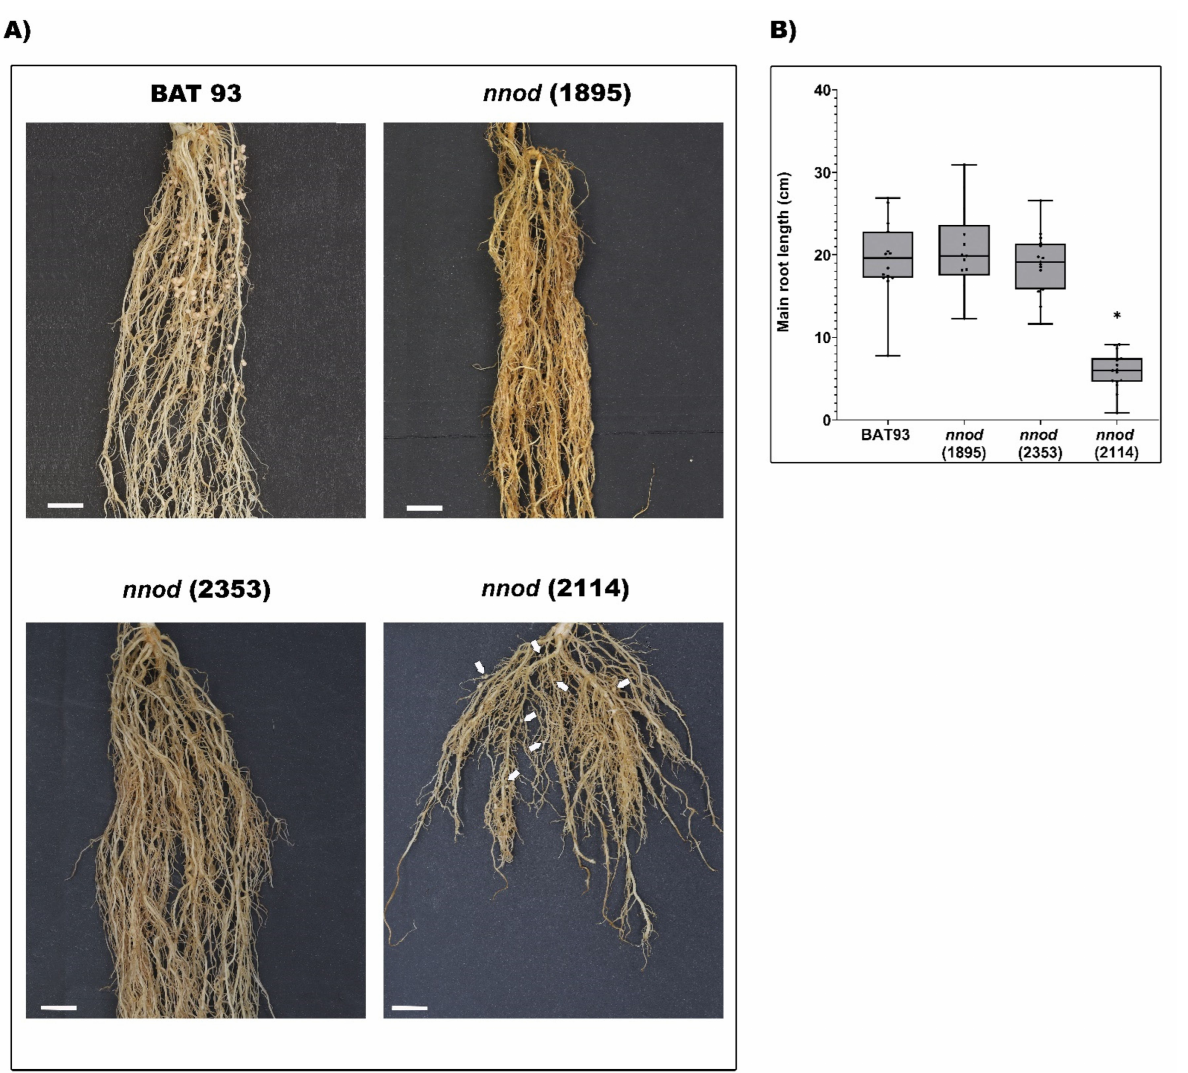
Figure 2. Nodulation and root growth of P. vulgaris BAT 93 and nnod mutants. ( A ) BAT 93 and nnod mutants after 25 dpi with R. etli CE3. White arrows point to the small-white pseudo-nodules formed in nnod (2114)-inoculated plants. Bar = 1 cm. ( B ) Length of the main root of WT and nnod mutant plants from at least 5 inoculated individuals per genotype. In box plots, horizontal box side represents the first and third quartile while the outside whiskers represents the minimum and maximal values. (*) significant difference of main root length between WT and each nnod mutant-inoculated root ( p ≤ 0.0001, Student’s t